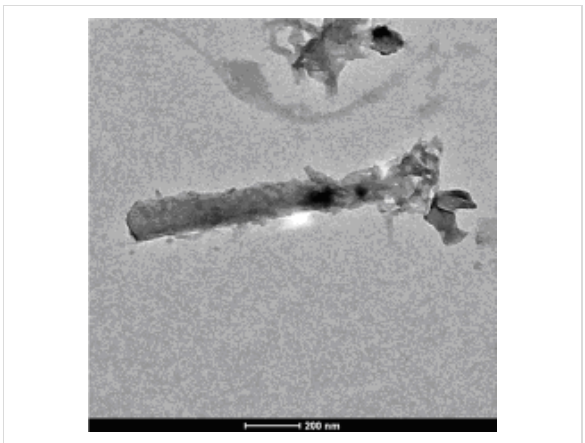
Figure 12: TEM image of a single SiNW/PEDOT after 30 s of tapering (corresponding to the sample in 11b).